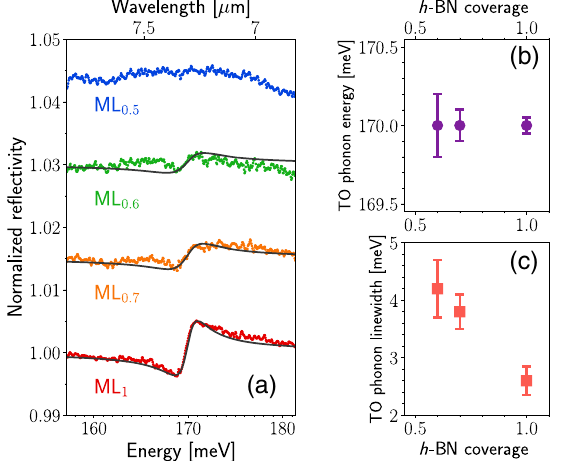
FIG. 4. (a) Reflectivity spectra in the midinfrared range for a set of four atomically thin h -BN epilayers with a coverage up to a continuous monolayer, at 300 K. Experimental data (symbols), fit of the reflectivity (solid lines). The spectra are normalized to the reflectivity spectrum from the bare graphite substrate (HOPG). The spectral range is centered at the energy of the E 0 TO phonon mode in h -BN. The energy and linewidth of the TO phonon mode are plotted as a function of h -BN coverage in (b) and (c),